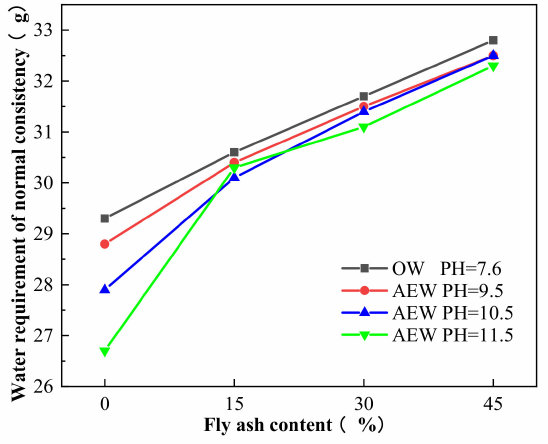
Figure 14. Comparison of the water requirement for a normal consistency of cement